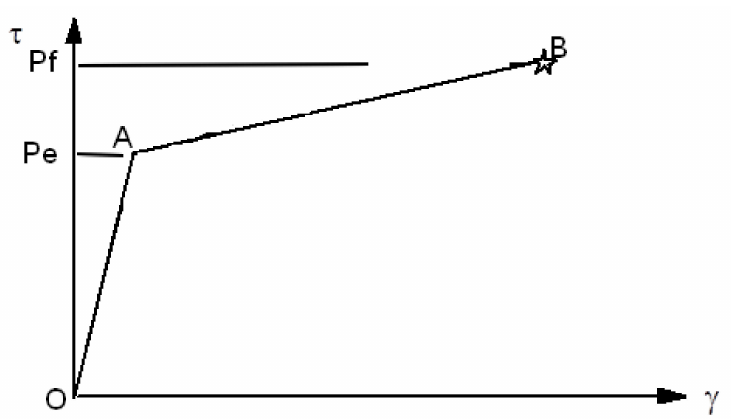
Figure A3. Schematic diagram of the adhesive shear stress versus shear strain relationship.